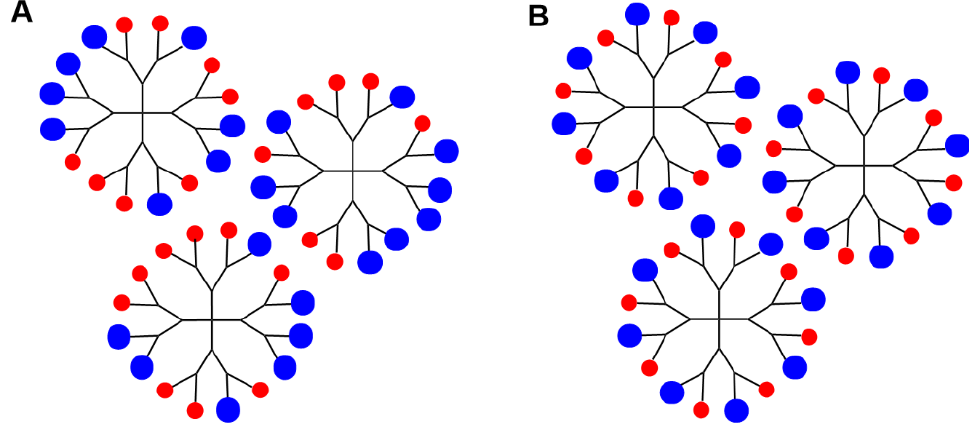
Figure 1. Examples of batches of bifunctionalized dendrimers. ( A ) Stochastic functionalization on the surface of dendrimers. ( B ) Precise bifunctionalization on the surface of dendrimers. The easiest way to get dendrimers specifically bifunctionalized on their surface consists in grafting on each terminal function a compound bearing already both desired functions (Scheme 1A). Such a method has been applied to different types of dendrimers and functions. One can cite for instance as an early example the presence of both a phenyl and a pyrene on the surface of a series of dendrimers built on an arylether scaffold, and used for studying charge-transfer processes from the core to the surface [7]. More recent examples concern PAMAM (polyamidoamine) dendrimers functionalized with different aminoacids, to have NH 2 groups together with either OH, SH, or other functional groups, and tested for drug delivery [8]. Polyester dendrimers functionalized with both OH and azide, used later on in click chemistry to afford biosensors [9], or functionalized with both azide and alkyne, as a multipurpose platform, in particular to afford implant adhesives in bone fracture applications [10] are other more recent examples. Azide alkyne monomeric compounds have been used for synthesizing by click chemistry multifunctional nanocarriers bearing as terminal functions a model drug (R-lipoic acid), a fluorescent dye (BODIPY), and a poly(ethylene glycol) (PEG) chain [11]. Other recent examples of grafting directly two functions concern PPI (polypropyleneimine) dendrimers functionalized with both an electroactive carbazole and a mesogenic unit, all dendrimers of this family being liquid crystalline [12], and also Newkome-type polyamide dendrimers, functionalized with both one azide and two olefins [13]. A series of bifunctional dendrimers has been obtained from either a polyester-polyamide, or polyester-lysine, or polyamine-lysine hybrid internal structure functionalized on the surface with orthogonally protected aspartic acid [14]. The selective and sequential deprotection of the amine and of the carboxylic acid of the protected aspartic acid was carried out to graft a long PEG (115 units in average), and either a gadolinium complex [15,16] or diverse other lanthanide complexes (Dy, Yb [17], Eu, and Sm [18]) for magnetic resonance imaging (MRI), or two synthetic tubulysin analogues against C26 colon carcinomas [19]. Lysine derivatives protected by two different protecting groups, were grafted on the surface of lysine dendrimers and dendrons. Selective deprotection afforded dendrimers bearing both gadolinium complexes and PEG as MRI contrast agents [20]. The same process was applied to a series of dendrons having a carboxylic acid at the core and both a gadolinium complex and galactosyl moieties on the surface, as liver targeting imaging probes [21]. Another lysine-dendron bearing a long PEG chain at the core (114 units in average) and both a porphyrin analogue and cholic acid, was used for near-infrared fluorescence imaging (NIRFI), magnetic resonance imaging (MRI), positron emission tomography (PET) and dual modal PET-MRI